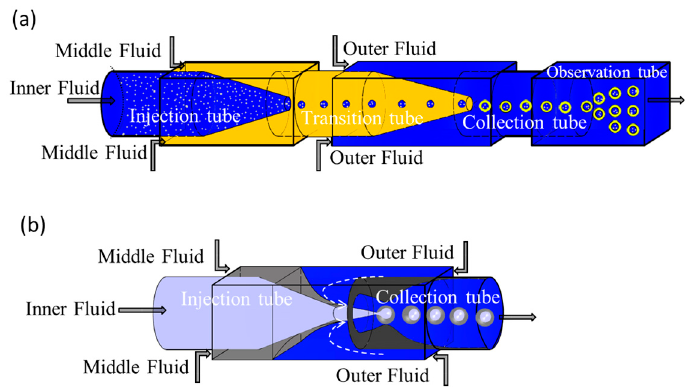
Figure 6. Fabricate of double emulsions in microfluidic devices. ( a ) Schematic of a capillary microfluidic device that combines double co-flowing geometry adapted from Figure 1 in [107]; ( b ) Schematic of a capillary microfluidic device that combines co-flow and flow-focusing geometry adapted from Figure 1 in [37].